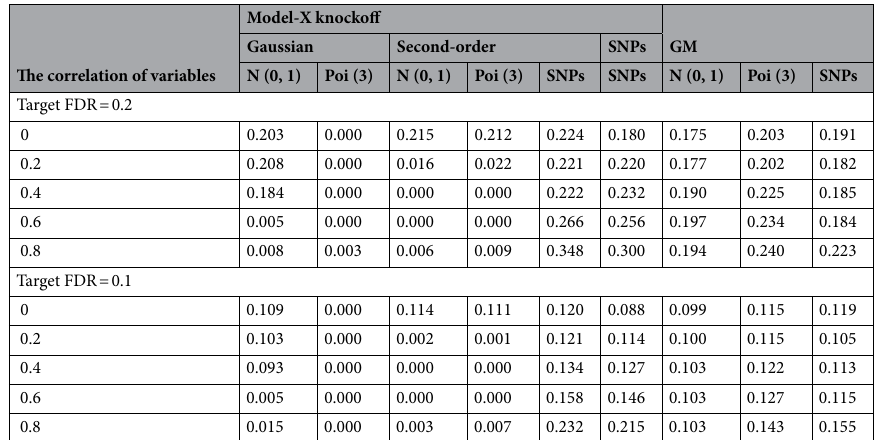
Table 3. The false discovery rate as correlations among explanatory variables increase (n = 500).